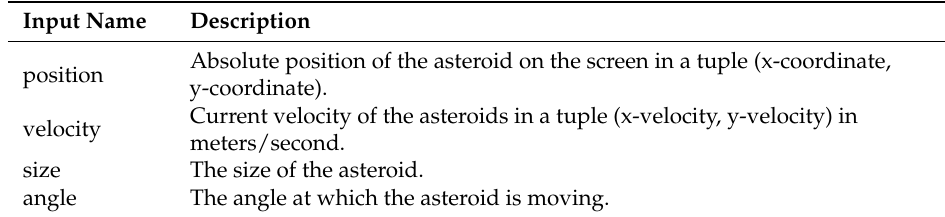
Table 1. Available inputs for each asteroid on the